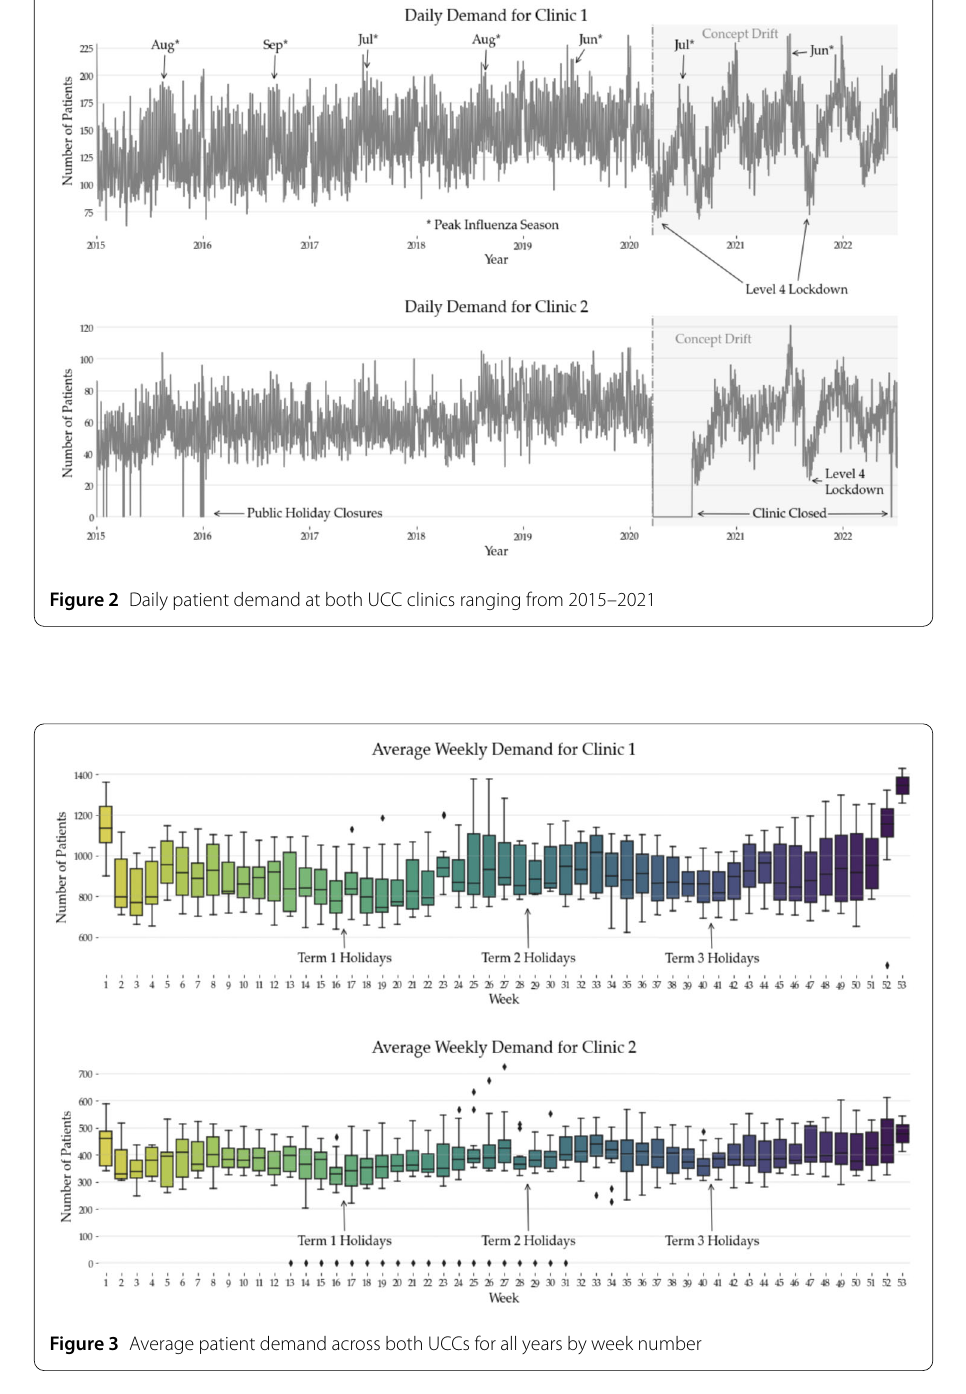
Figure 4 shows average patient arrival patterns across both clinics by day of the week. A peak in patient presentations tends to occur during the weekend when GPs are closed, which is followed by a decrease in patient flows at the start of the working week, which then reaches minima by